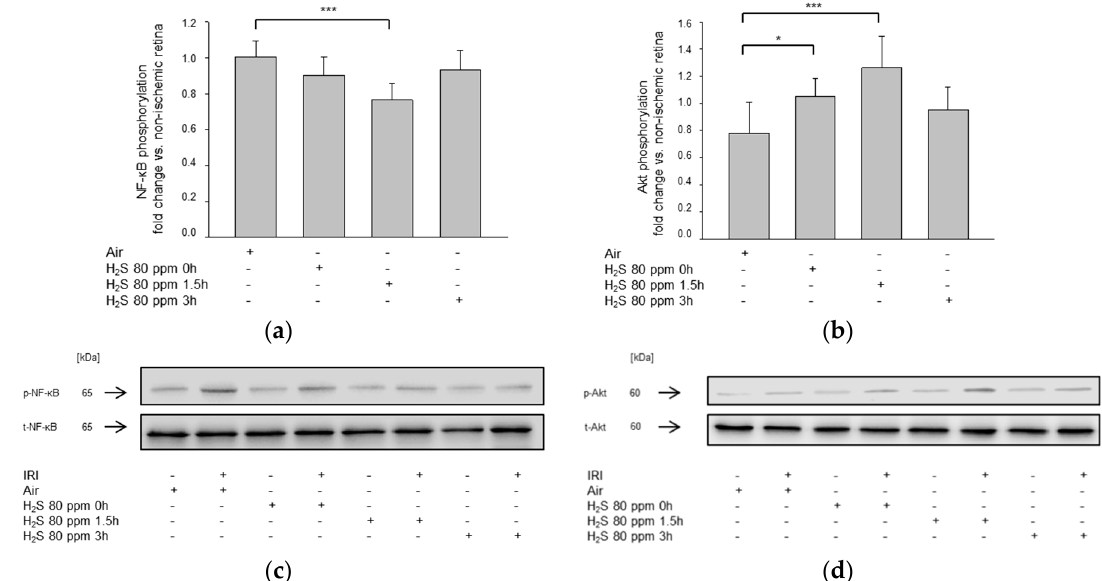
Figure 9. ( a , c ) Effect of H 2 S inhalation on the retinal expression of NF- κ B phosphorylation. Densitometric analysis of n = 8 Western blots for NF- κ B phosphorylation after time-dependent inhalation of 80 ppm H 2 S (data are mean ± SD, n = 8; *** = p < 0.001, IRI vs. IRI + 80 ppm H 2 S at 1.5 h) and representative Western blot image ( n = 8) showing the suppression of retinal phosphorylation of NF- κ B compared to total NF- κ B. ( b , d ) Effect of H 2 S inhalation on the retinal expression of Akt phosphorylation. Densitometric analysis of n = 8 Western blots for Akt phosphorylation after time-dependent inhalation of 80 ppm H 2 S (data are mean ± SD, n = 8; *** = p < 0.001, IRI vs. IRI + 80 ppm H 2 S at 1.5 h, and * = p < 0.05, IRI vs. IRI + 80 ppm H 2 S at 0 h) and representative Western blot image ( n = 8) showing the increase of retinal phosphorylation of Akt compared to total Akt.